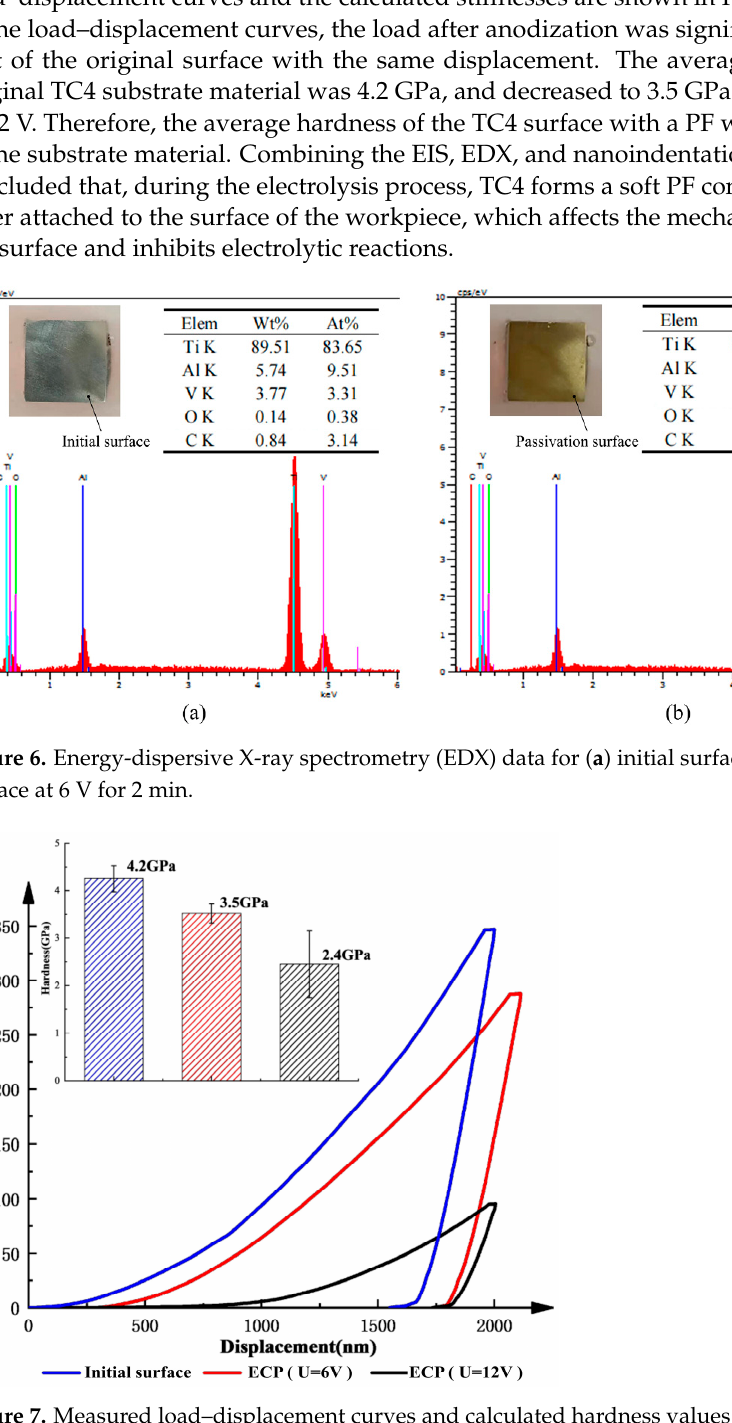
Figure 7. Measured load–displacement curves and calculated hardness values. were analyzed by EIS. The specific pretreatment methods are described in Table 5.